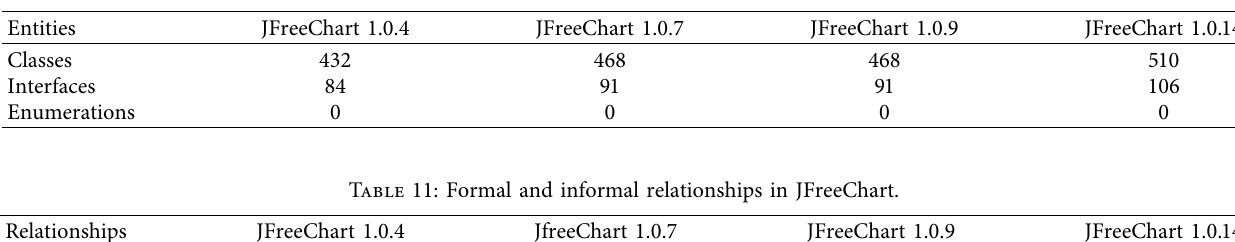
Table 10: Entities in JFreeChart.